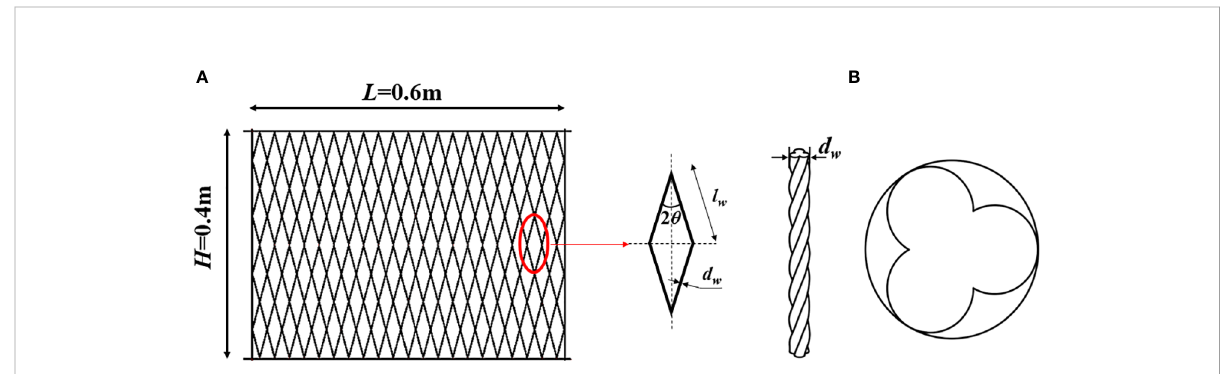
FIGURE 2 Geometric description of the net panel. (A) The overall geometry and (B) twisted twine and its cross-section. The effective diameter of the twisted twine is the diameter of the circumcircle (McKenna et al., 2004; Evans and Ridge, 2005; Lader et al.,